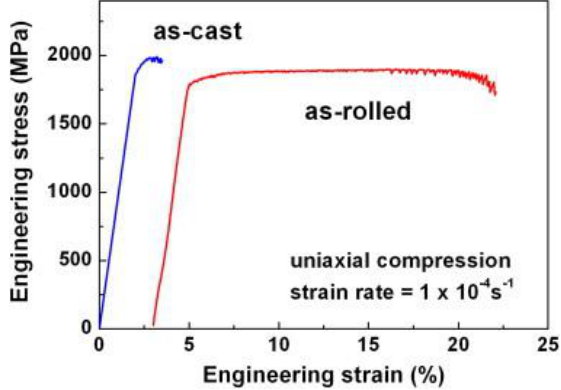
Figure 12. Compressive stress–strain curves of as-cast and cold-rolled Ti 40 Zr 25 Ni 8 Cu 9 Be 18 BMG samples. Reproduced with permission from [186]. Copyright 2012,